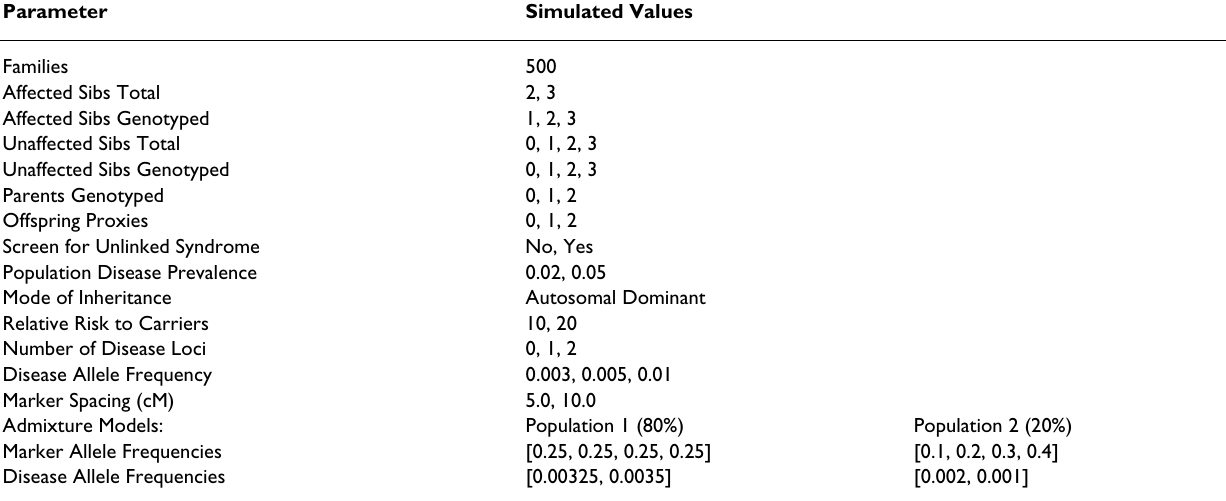
Table 1: Parameters employed in